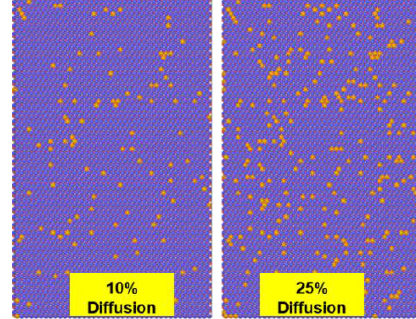
Figure 5. The atomistic model of monolayer MoS 2 with different percentage of antisite defects. Table 3. The geometry optimized structural parameters for MoS 2 for different defect fractions of antisite defects along with Standard Deviation (SD).